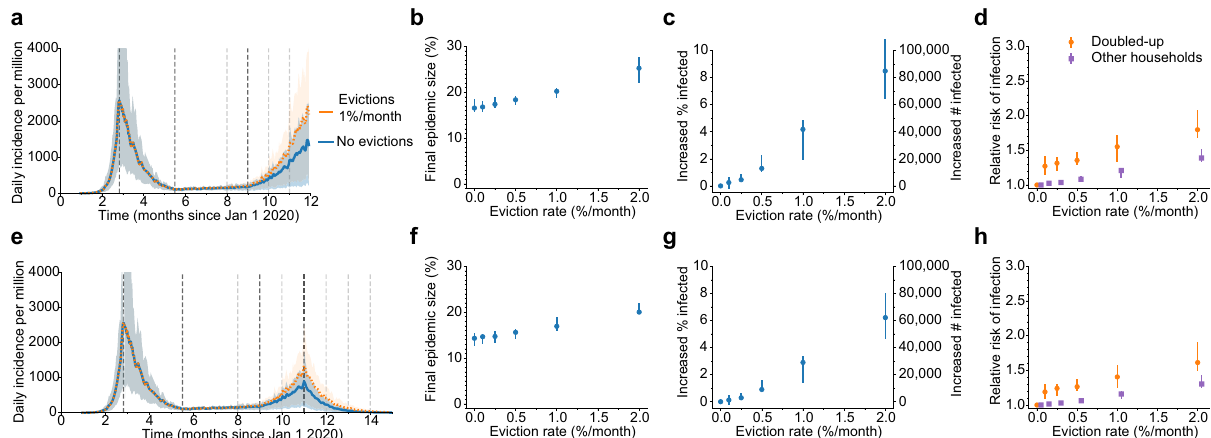
Fig. 2 Impact of evictions on a SARS-CoV-2 comeback during Fall 2020. We model evictions occurring in the context of an epidemic similar to cities following “ Trajectory 1 ” , with a large fi rst wave and strong control in the spring, followed by relaxation to a plateau over the summer and an eventual comeback in the fall. Monthly evictions start Sept 1, with a 4-month backlog processed in the fi rst month. a The projected daily incidence of new infections (7-day running average) with and without evictions. Shaded regions represent central 90% of all simulations. The fi rst lockdown (dotted vertical line) reduced external contacts by 85%, under relaxation (second dotted line) they were still reduced by 70%, and during the fall comeback, they were reduced by 60% (fourth dotted line). b Final epidemic size by Dec 31, 2020, measured as a percent of individuals who had ever been in any stage of infection. c The predicted increase in infections due to evictions through Dec 31, 2020, measured as the excess percent of the population infected (left Y -axis) or the number of excess infections (right Y -axis). d The relative risk of infection in the presence vs. absence of evictions, for individuals who merged households due to evictions ( “ Doubled-up ” ) and for individuals who kept their pre-epidemic household ( “ Other households ” ). Data in b – d shown as median values with interquartile ranges across simulations. e – h Same as above but assuming a second lockdown is instituted on Dec 1 and maintained through March